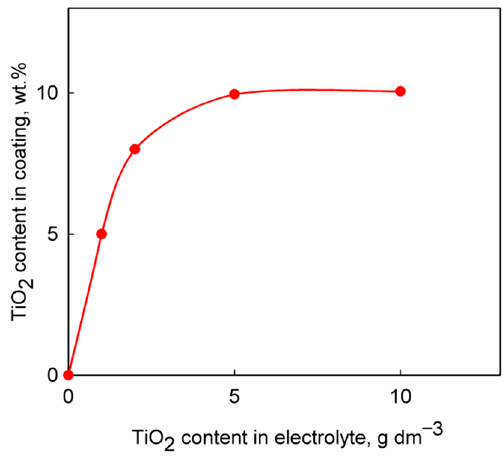
Figure 1. Variation in the content of titania in composite coatings with TiO 2 concentration in the colloidal plating solution.